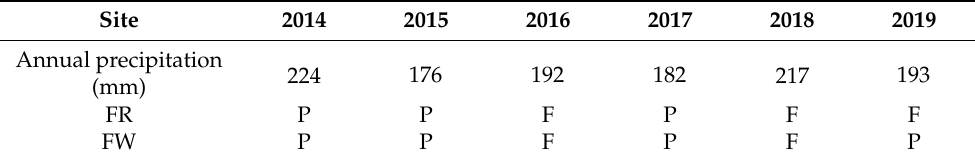
Table 2. Production history and annual precipitation from 2014 to 2019 in FR and FW. The annual precipitation was obtained from a weather station at Hustai National Park located 11–13 km southeast of the study